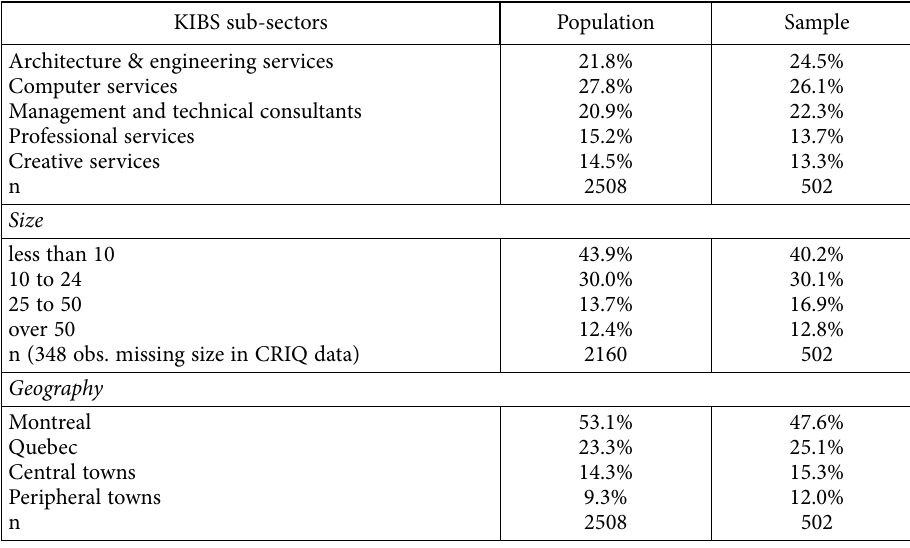
Table 2A. Principal component analysis: importance of information sources